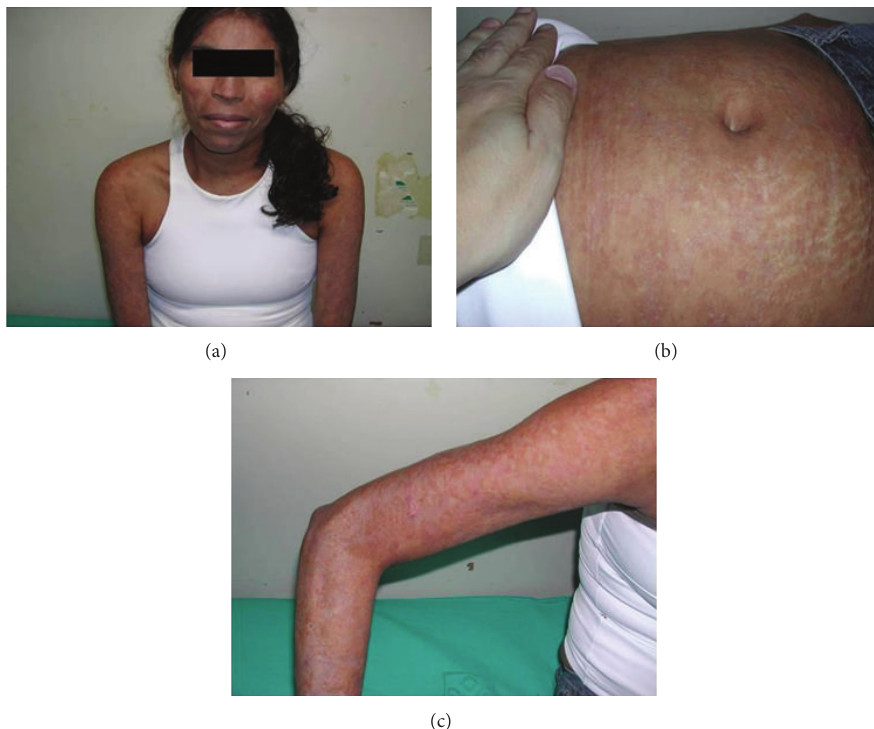
Figure 5: After 30 days of treatment, the lesions on the face (a), abs (b), and the upper limb (c) showed improvement.